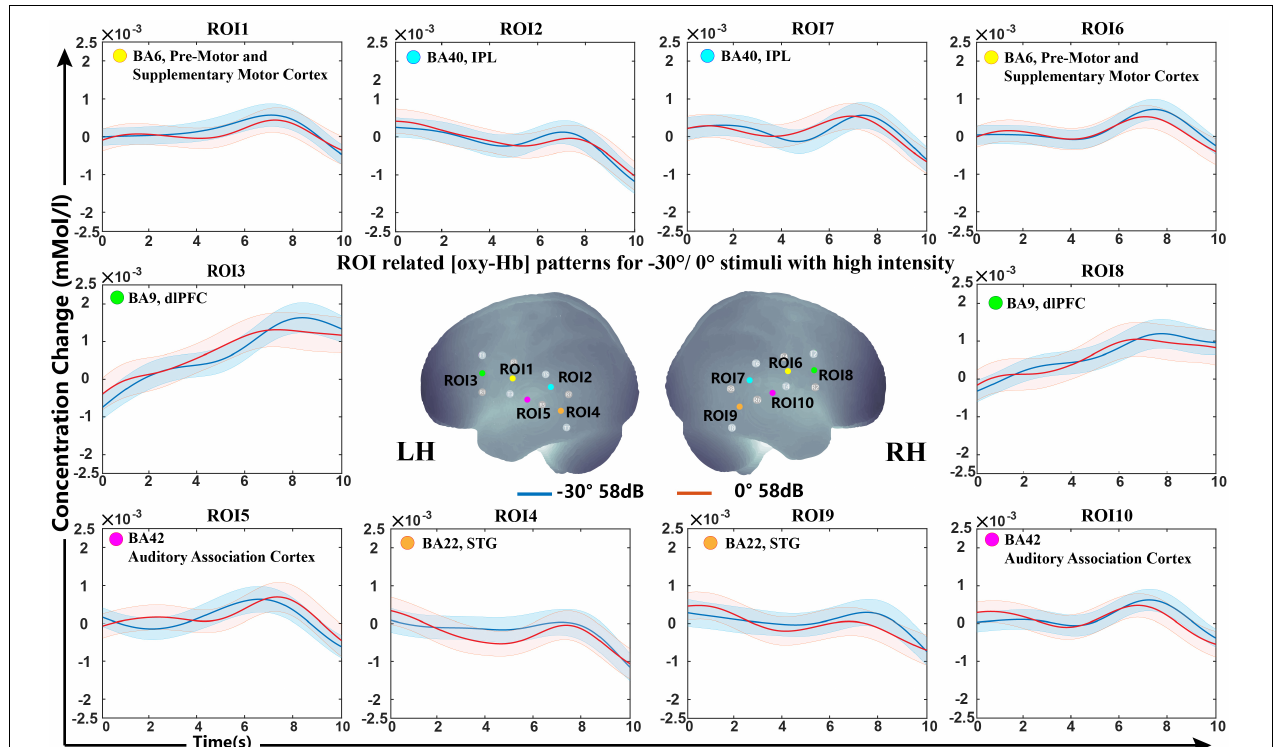
FIGURE 5 | Grand-averaged [oxy-Hb] responses recorded from different locations (–30 ◦ /0 ◦ ) in high sound intensity (58 dB) for all ROIs and the optimally selected feature